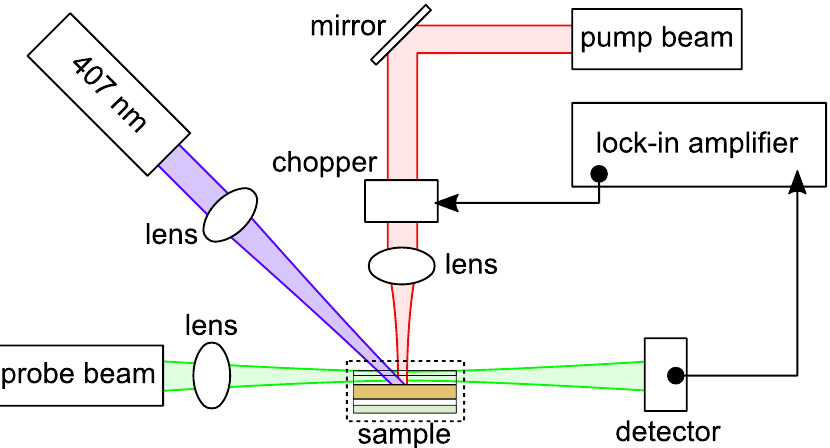
Figure 2. Schematic diagram of the experimental setup of the BDS method. Probe beam intensity is 2 mW. Pump beam intensity is 35 mW. An additional 407 nm laser was used to continuously photoexcite the active layer of organic solar cell, labeled as sample.